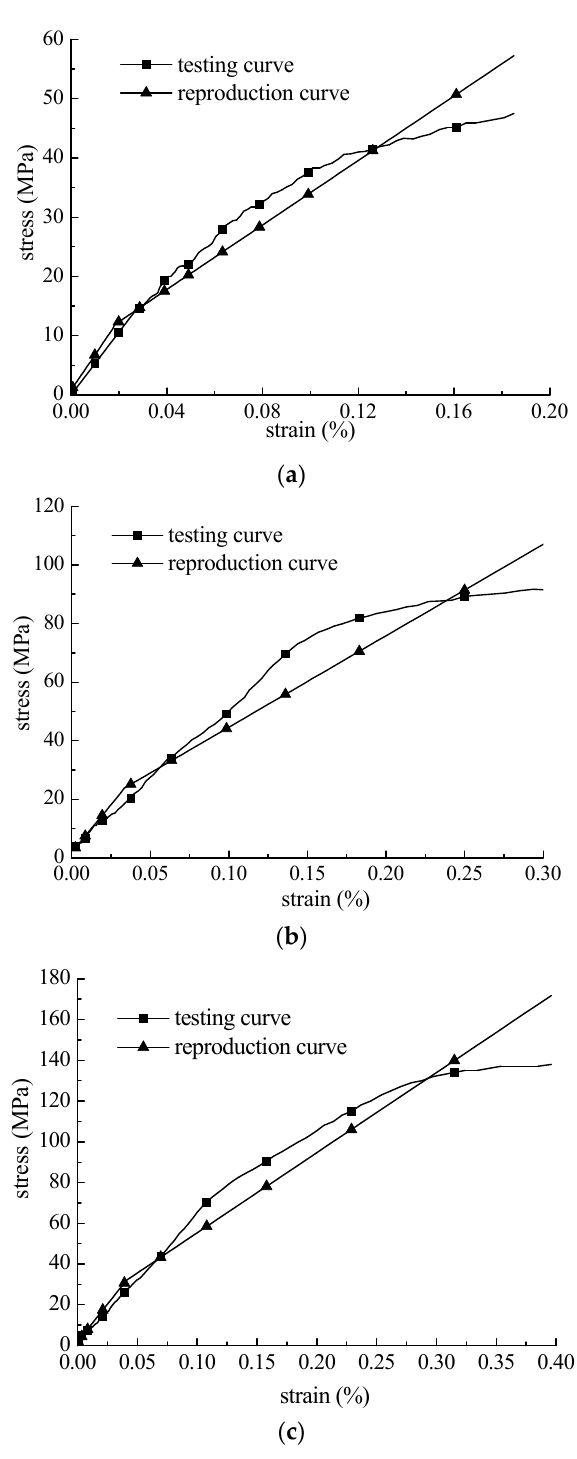
Figure 5. Viscoelastic-plastic dynamic stress-strain curves. ( a ) Strain rate: 87 s − 1 ; ( b ) strain rate: 194 s − 1 ; ( c ) strain rate: 260 s − 1 .